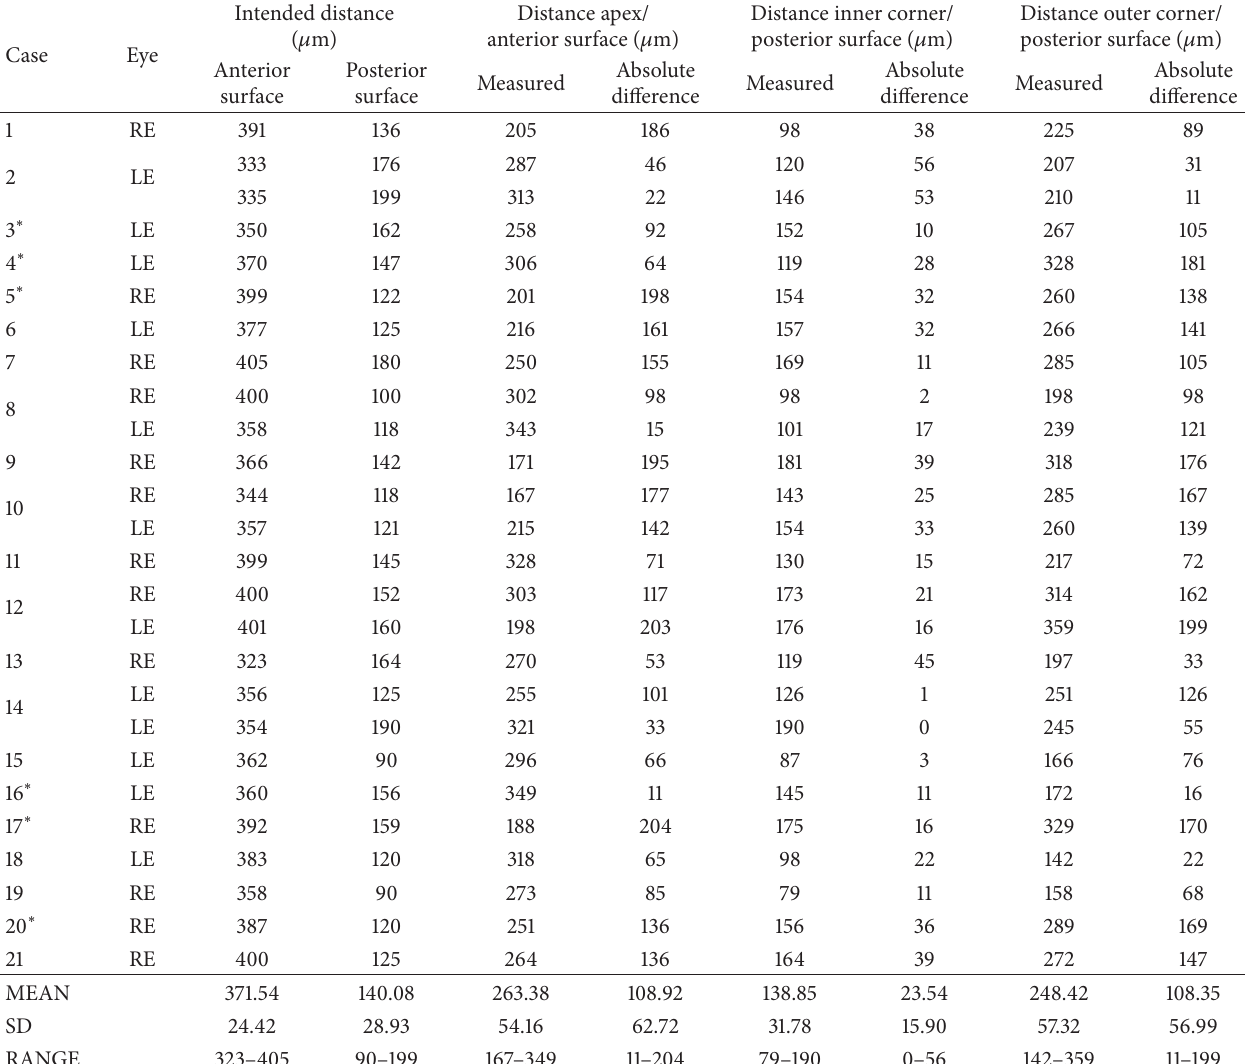
Table 2: Keraring measured and intended distance from the anterior and the posterior corneal